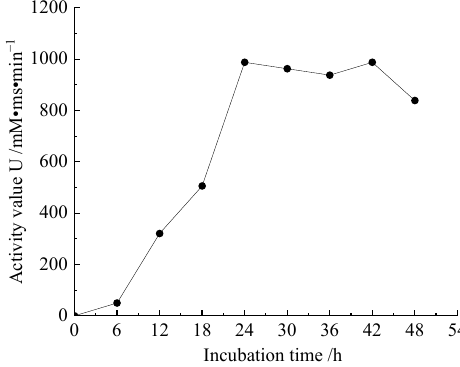
Figure 2. Variation diagram of bacterial activity.